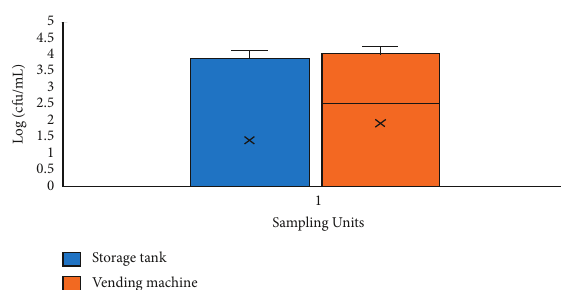
Figure 8: Variation of Staphylococcus aureus in milk from storage tanks and vending machines.